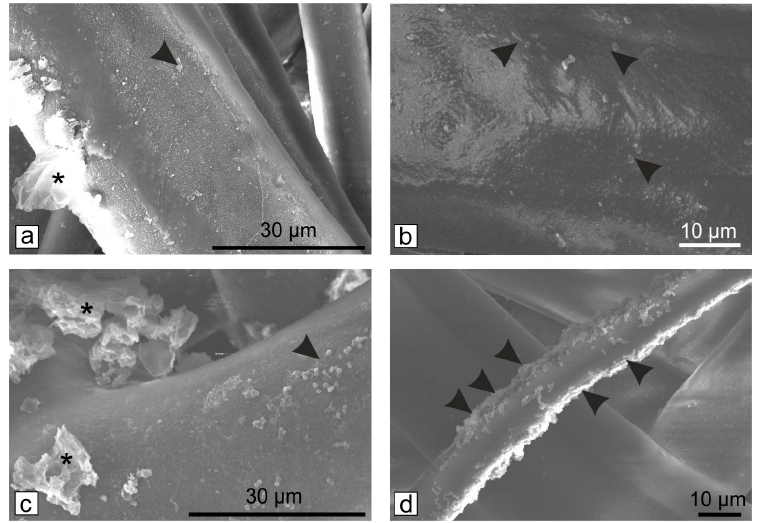
Figure 6. SEM micrographs of HEPA filters modified with 2 mg/mL Gr-Ag (5 wt% Ag) hybrid (asterisk) for 60 min and incubated with E. coli ( a , b ) and S. aureus ( c , d ) for 24 h at 37 ◦ C; black arrowheads indicate the presence of bacteria on the fibers; bare HEPA filters ( b – d ).